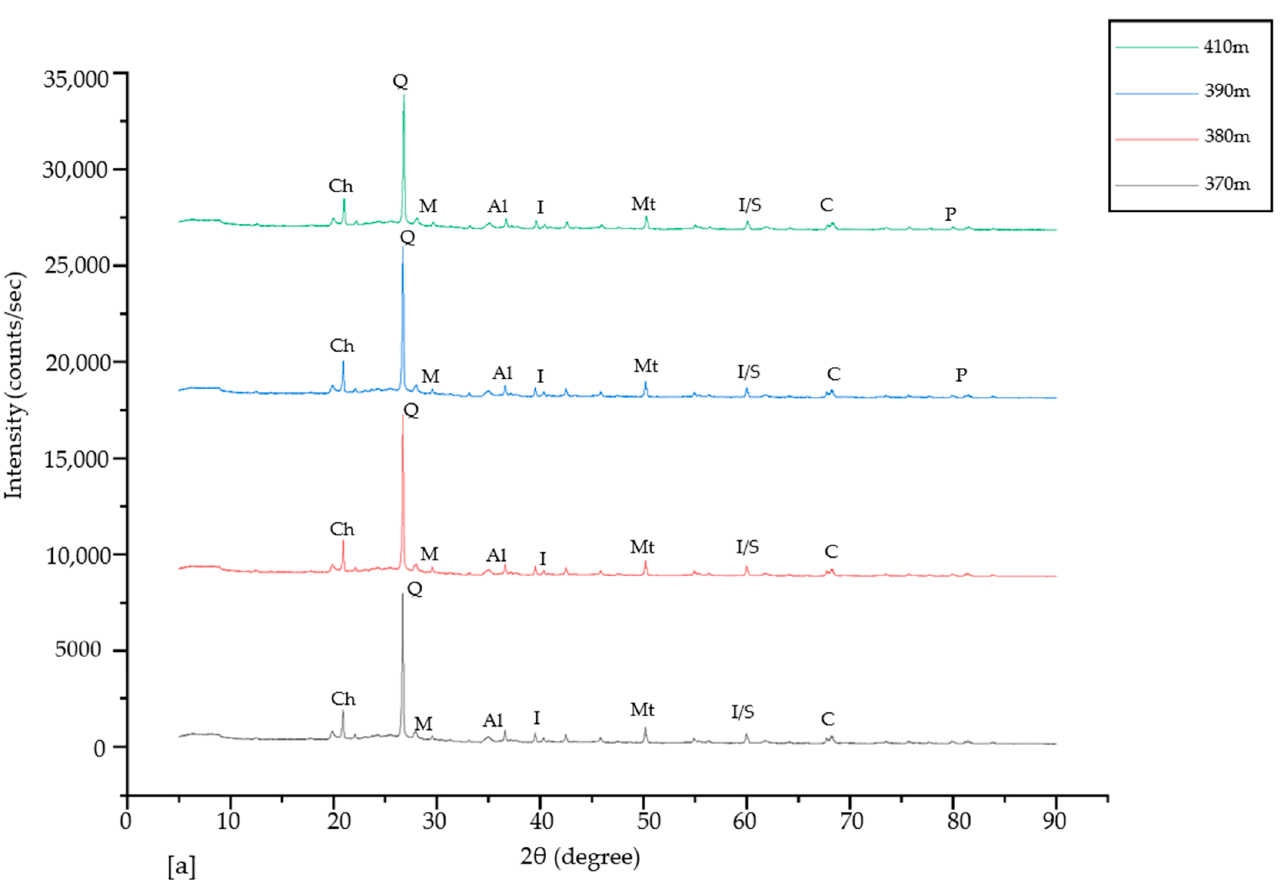
Table 1. Mineral composition of the carbonaceous shale samples from different depths.